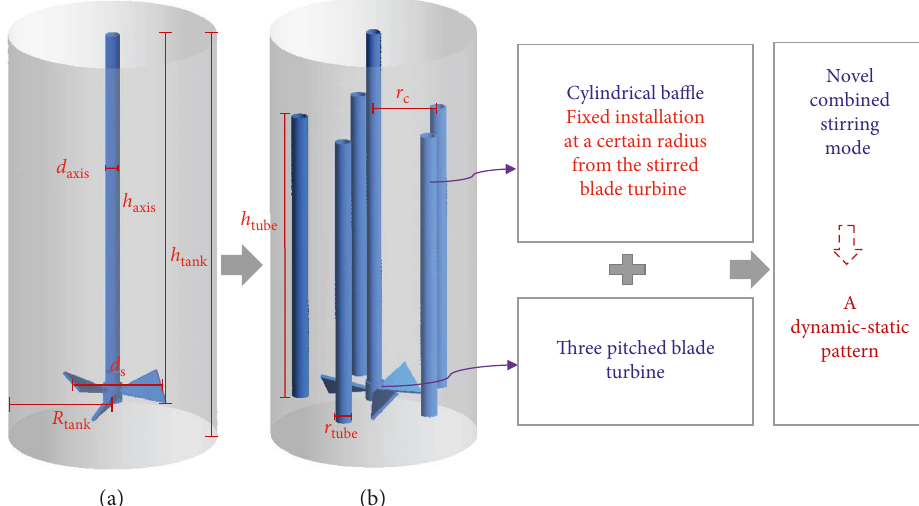
Figure 1: Schematic of the stirred tank. (a) Traditional chromite leaching stirred reactor. (b) Dynamic-static combined chromite leaching stirred